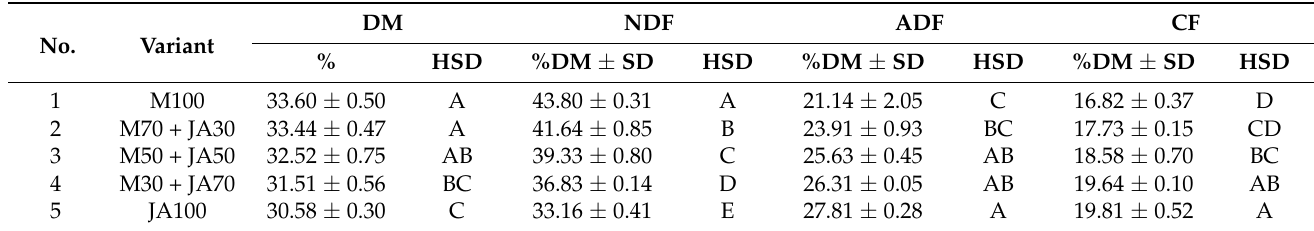
Table 4. DM, NDF, ADF and CF contents in the prepared model silages.